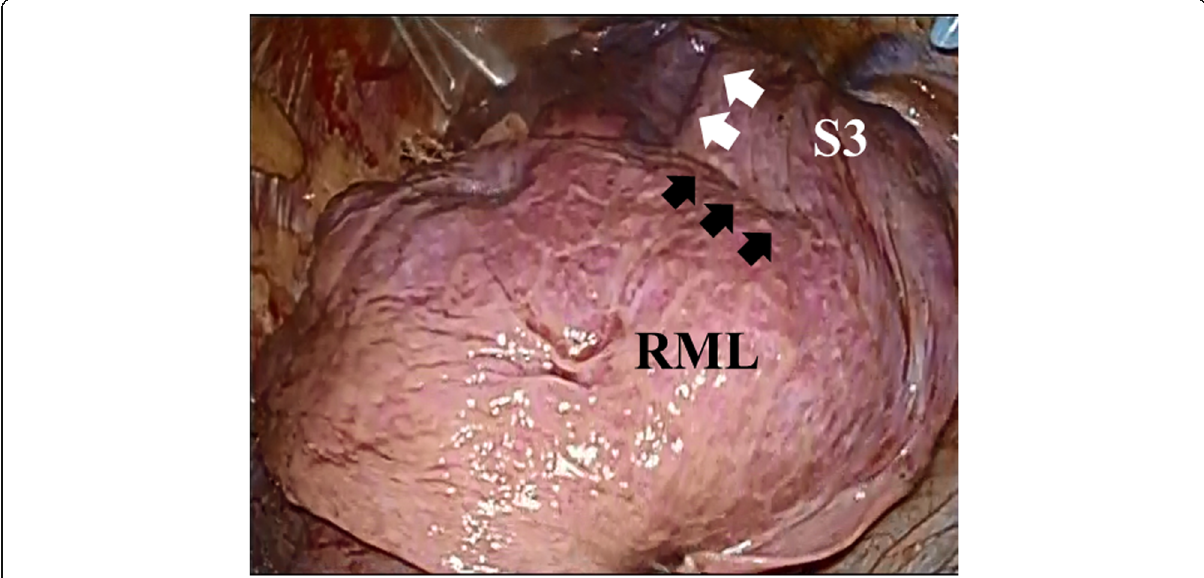
Fig. 1 The intraoperative photograph. The incomplete interlobar fissure between the right upper and middle lobe deemed to be complicated to perform UVATS. Black arrows indicate the incomplete interlobar fissure. White arrows indicate the abnormal lobulation of the S3. RML, right middle